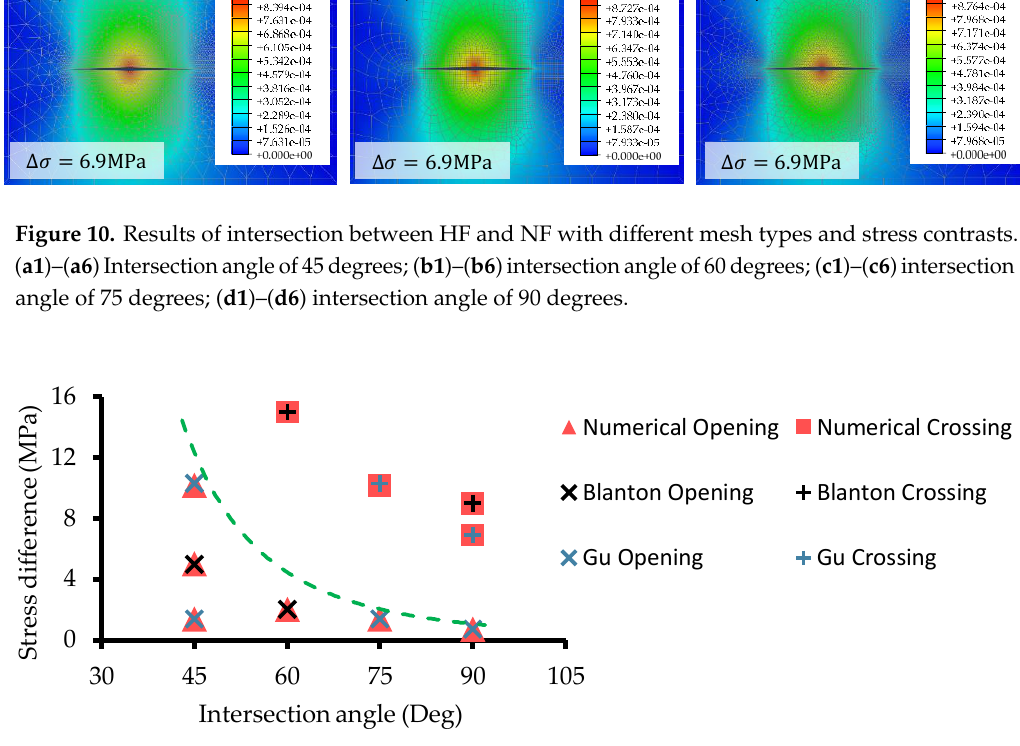
Figure 11. Comparison between experimental results and numerical results.